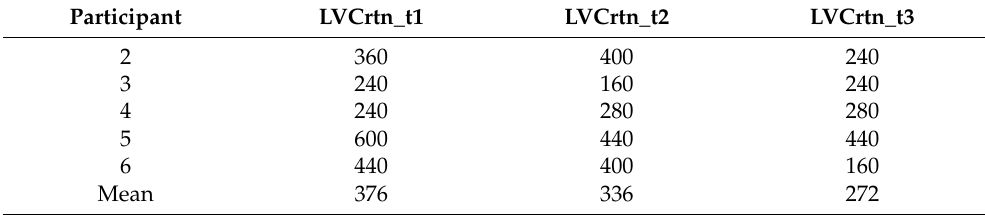
Table 20. LVCrt, nectar 10 mL (ms) individual and mean measurements at three assessment time